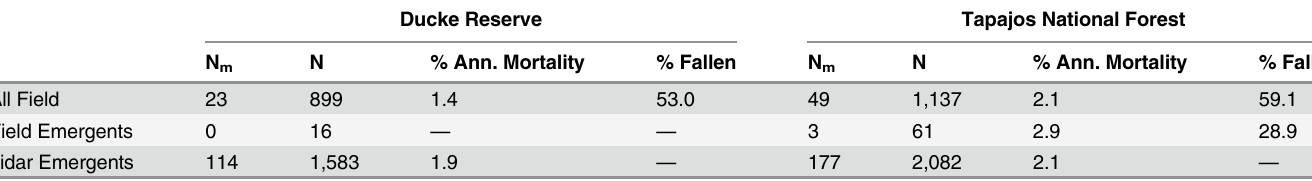
Table 4. Estimates of annual mortality based on field and lidar samples. Ducke Reserve Tapajos National Forest N m N % Ann. Mortality % Fallen N m N % Ann. Mortality % Fallen All Field 23 899 1.4 53.0 1,137 2.1 59.1 Field Emergents 0 16 — — 3 61 2.9 28.9 Lidar Emergents 114 1,583 1.9 — 177 2,082 2.1 — Field based estimates were calculated for all trees as well as emergent trees ( > 40 m). Lidar-based estimates of annual mortality are for emergent trees only ( > 40 m). Columns indicate the number of dead trees (N m ), total sample size (N), and the proportion of annual mortality between fi eld or lidar sampling intervals. Fallen dead trees had heights < 10 m in the 2011